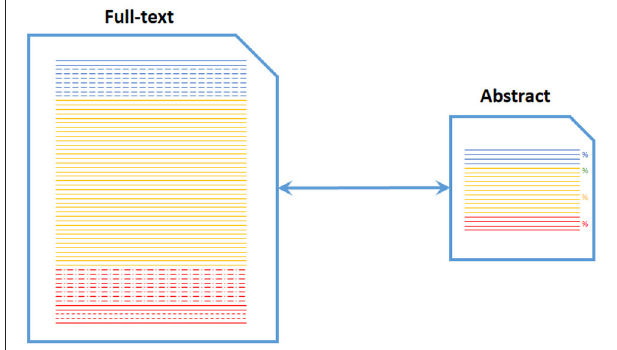
FIGURE 2 | Principle of GEM score as a comparison between the full text and abstract relying on detection of